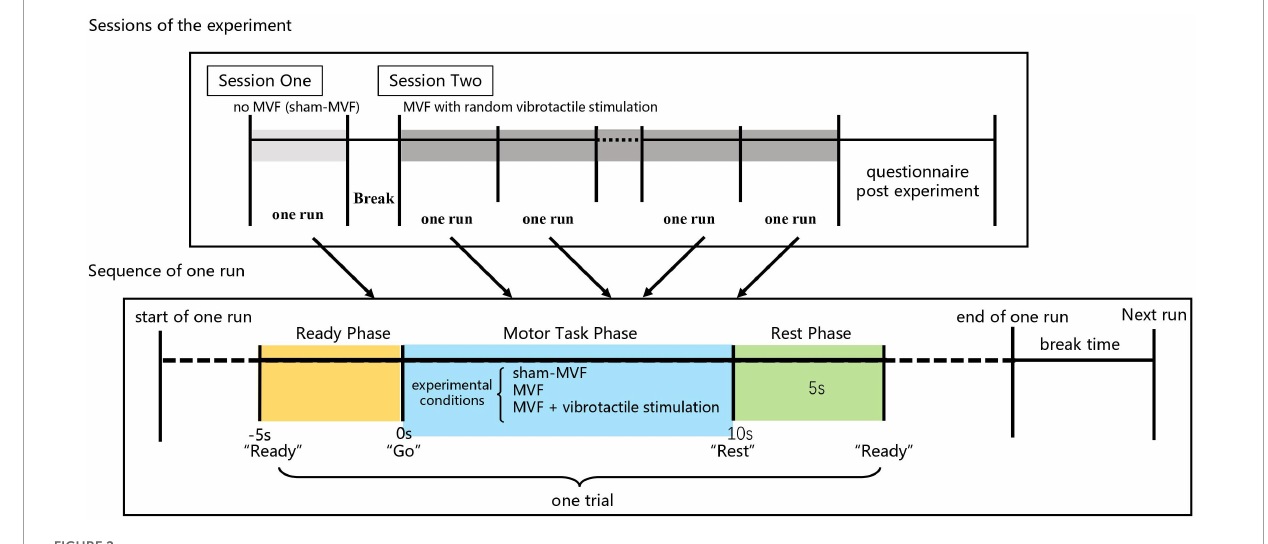
FIGURE2 Experimental paradigm and sequence of events in each